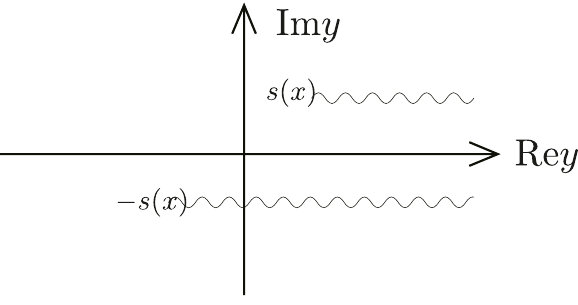
Figure 3 . The wavy lines are the paths of integration in the Borel summation. The paths overlap when Im[ s ] = 0